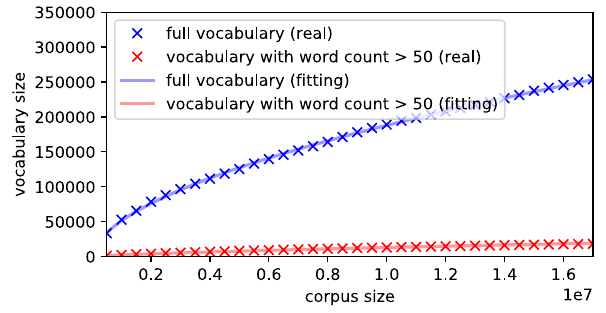
Fig. 8 The cumulative vocabulary size versus corpus size on